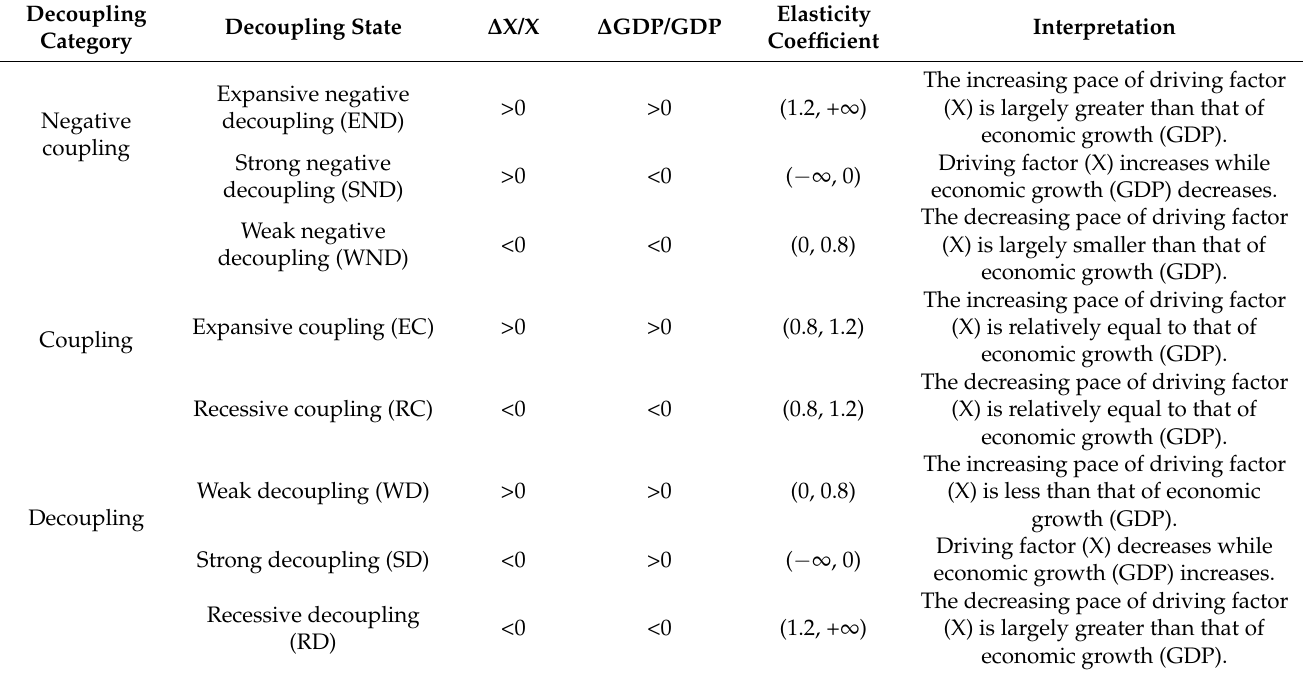
Table 2. Eight possible decoupling outcomes and their